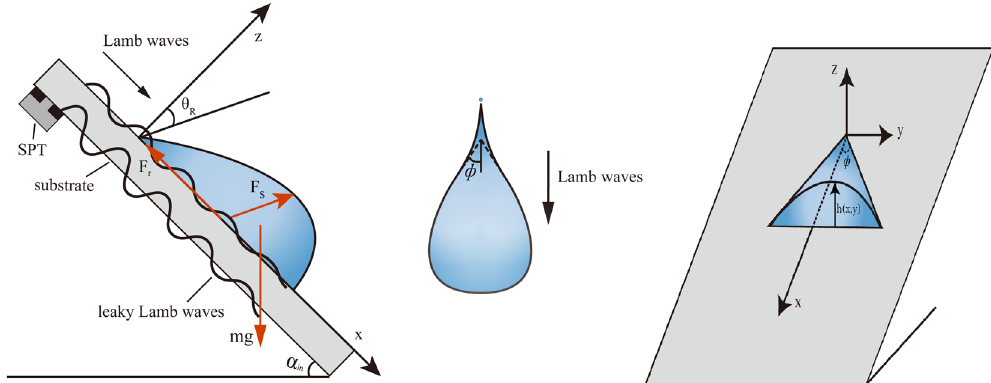
Figure 1. Schematic diagram of mode conversion of Lamb waves into compressional sound waves at the liquid- solid boundary of the droplet resulting in leaky Lamb waves on an inclined substrate at an inclination angle of α Φ is the half angle of the receding contact line in in . ( a ) Side view of a drop running down a plate, ( b ) notation macroscopic region, ( c ) the structure at the rear of sliding drop.